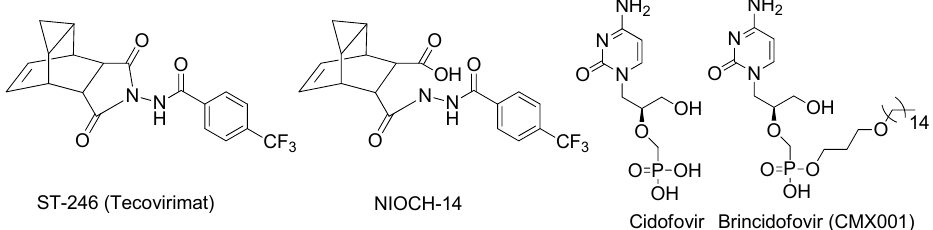
Figure 1. Some compounds currently approved for the treatment of VARV or are in clinical